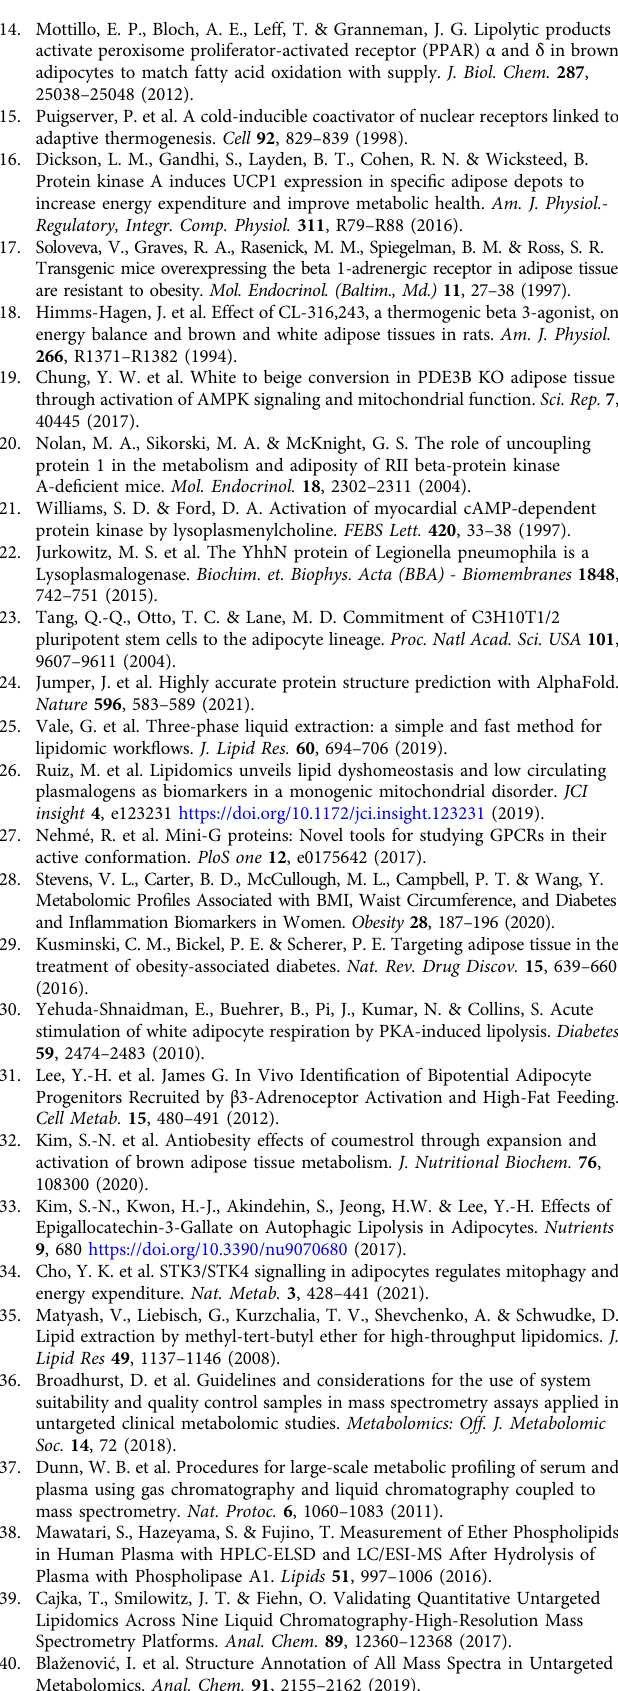
Statistics . The number of mice used in animal experiments is described within the associated fi gure legend. GraphPad Prism 7 software (GraphPad Software, USA) was used for statistical analysis. Data are presented as mean ± standard errors of the mean (SEM) or mean ± standard deviation (SD) as indicated in the Figure Legends. Statistical signi fi cance between two groups was determined by unpaired t - test. Comparisons among multiple groups were performed using a one-way